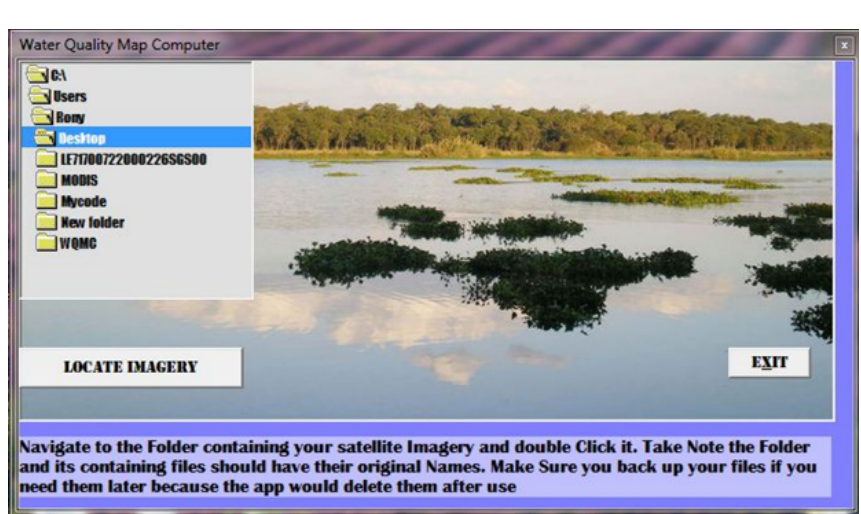
Figure 6. Interface of the backend application for automated remote sensing and